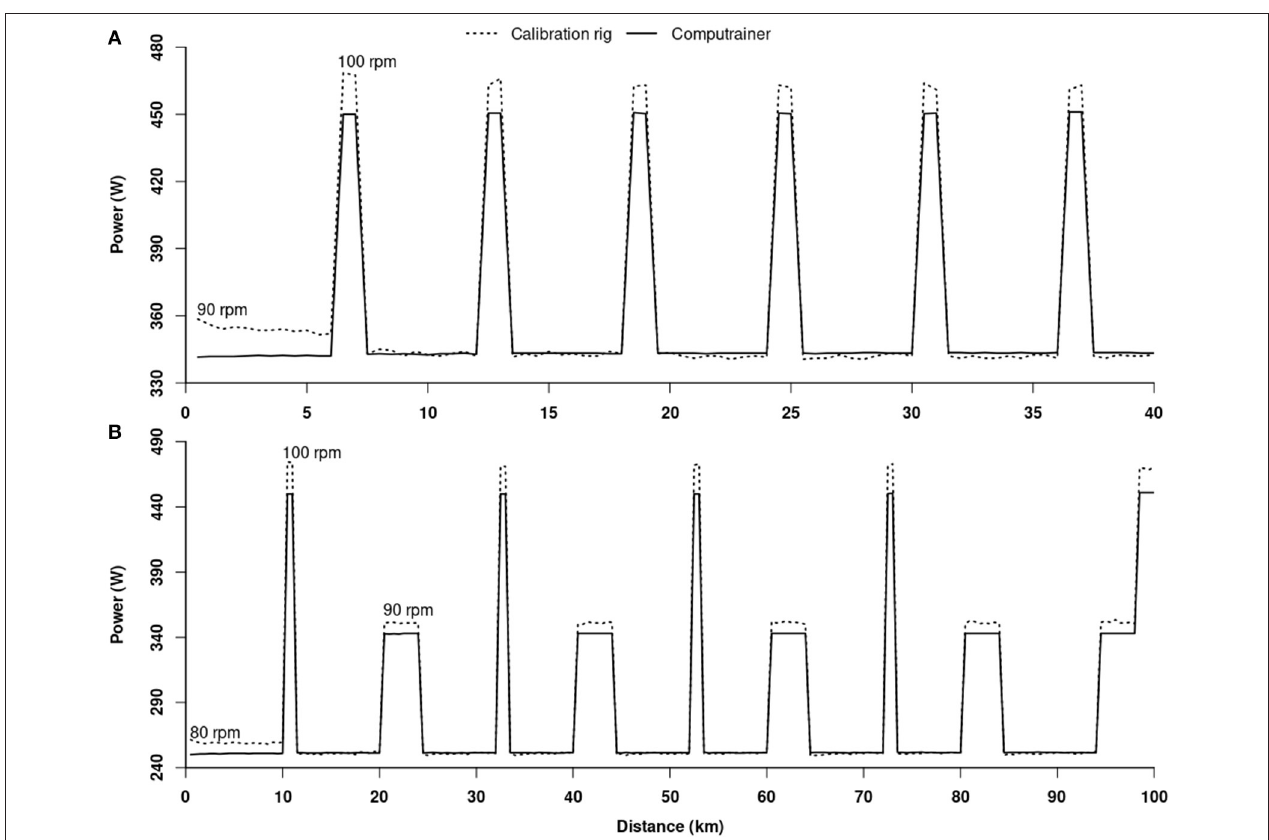
FIGURE 2 | Changes in workloads recorded by the CT and calibration rig during the 40 (A) and 100 (B) km time-trials.